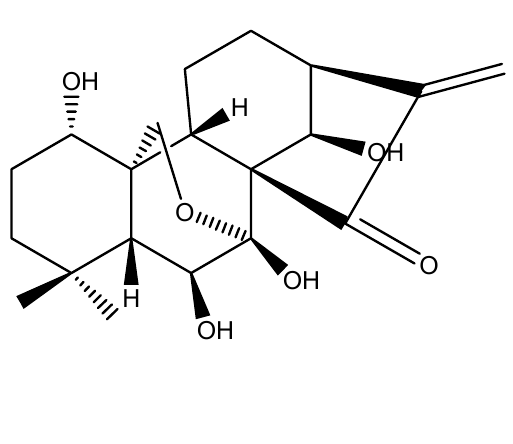
Figure 1. The structure of